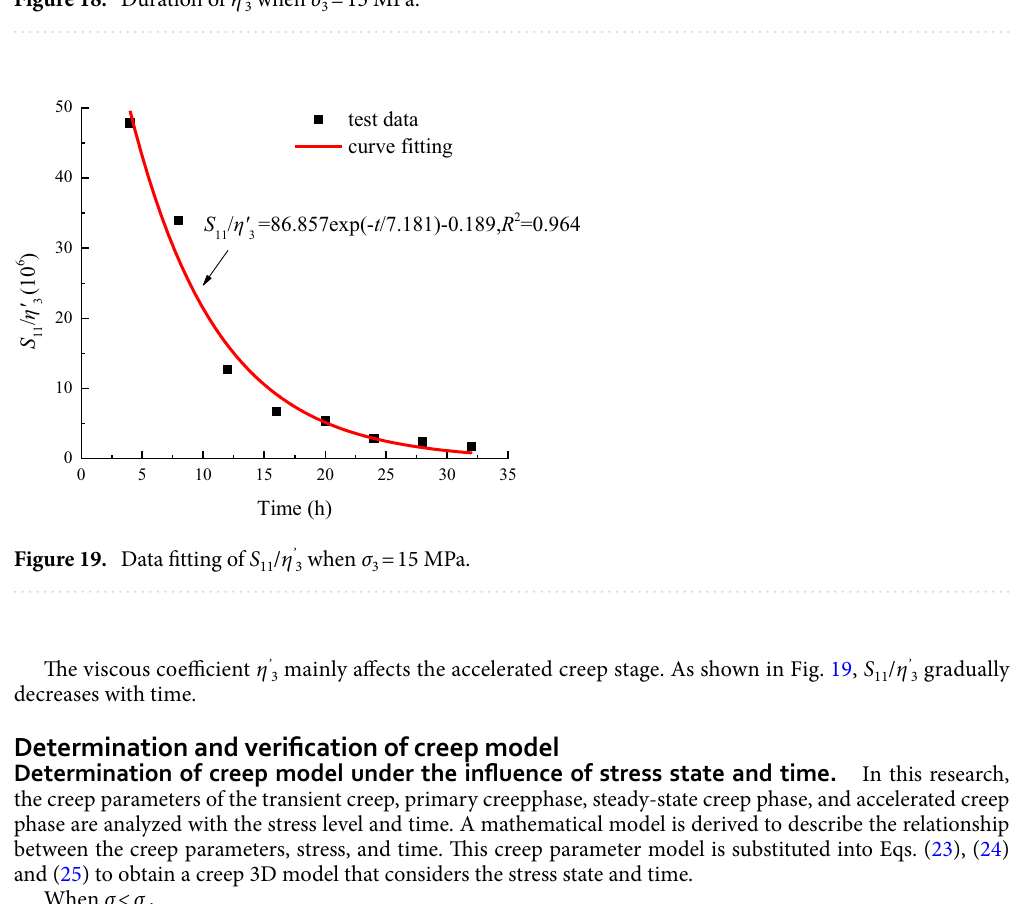
Figure 18. Duration of η ’ 3 when σ 3 = 15 MPa.